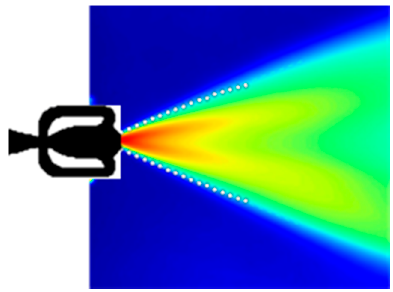
Figure 7. Spray image analysis, highlighting the angle of the spray (dotted lines) and the fuel flow density (brightness is connected to local mass flow rate intensity—red = high; yellow = medium; green = low). Mass flow distribution is retrieved from spray photo light intensity.